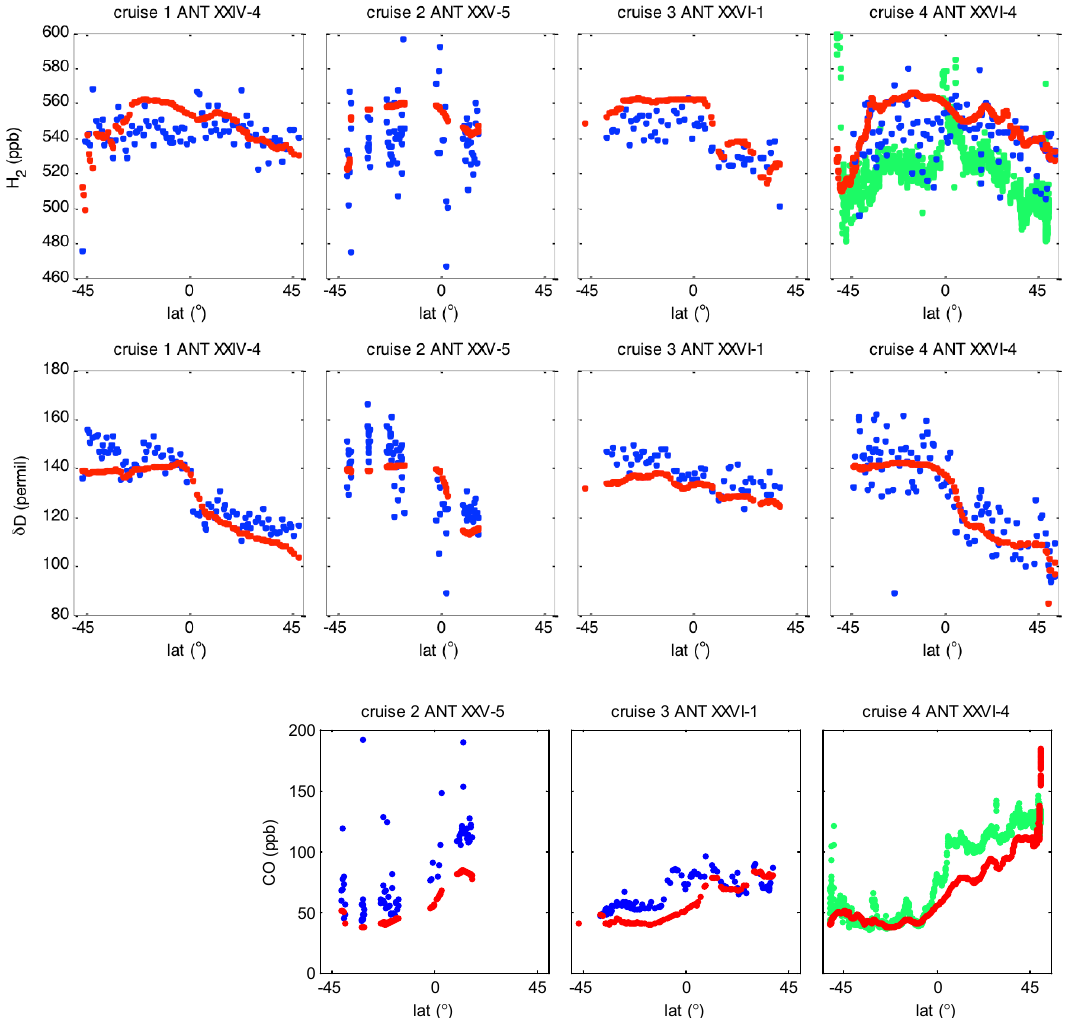
Figure 5. Comparison of measurement results of H 2 and CO mole fractions and δ D with TM5 model results (given in red). Data are shown against latitude. The blue markers show results of flask samples, and the green markers represent the continuous in situ measurements (performed with the peak performer instrument on–board). CO has not been analysed in the flasks sampled during the last cruise. The model data were interpolated at the place and time of sampling or